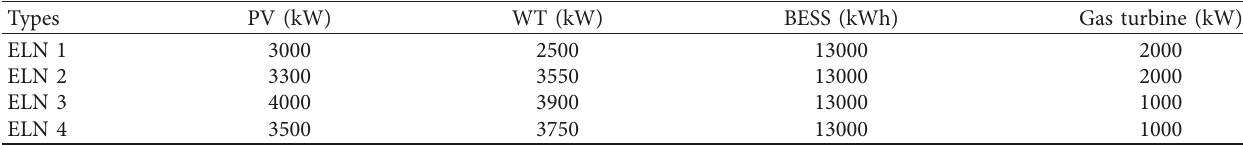
Table 1: The basic parameters of ELN.